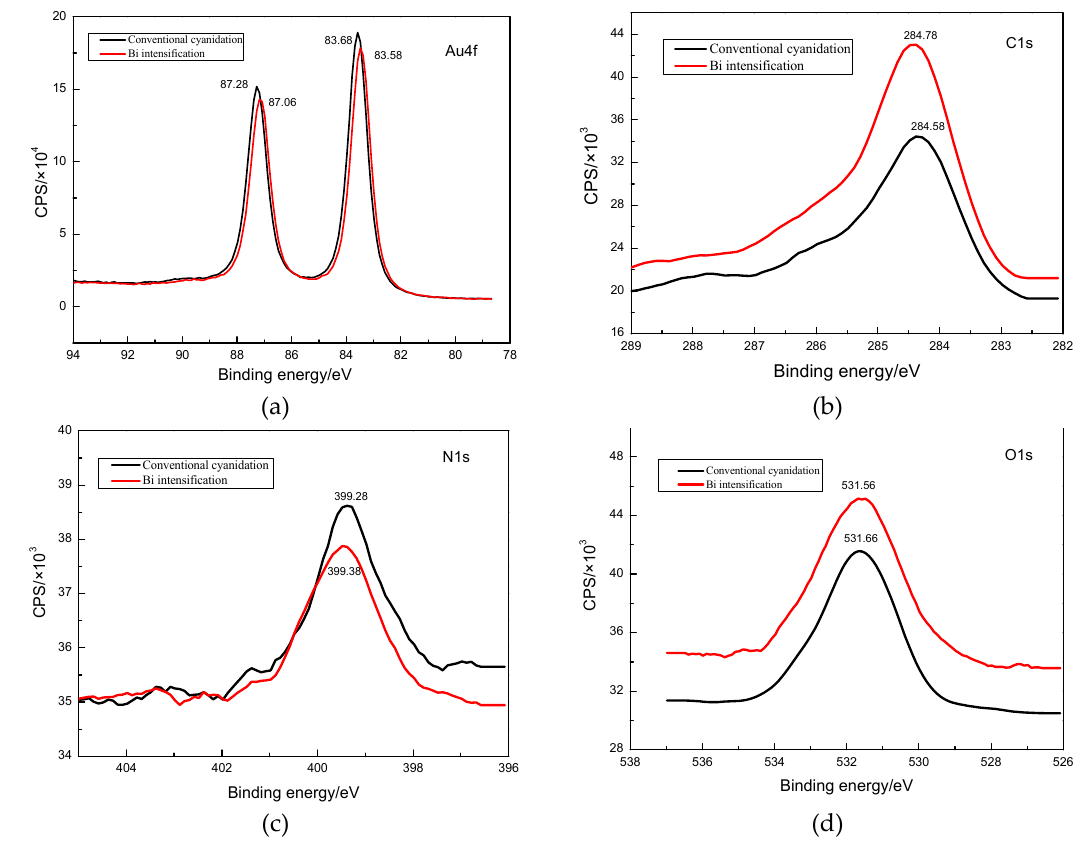
Figure 8. ( a ) Au4f, ( b ) C1s, ( c ) N1s, and ( d ) O1s XPS spectra of gold under conventional and Bi intensification cyanidation.